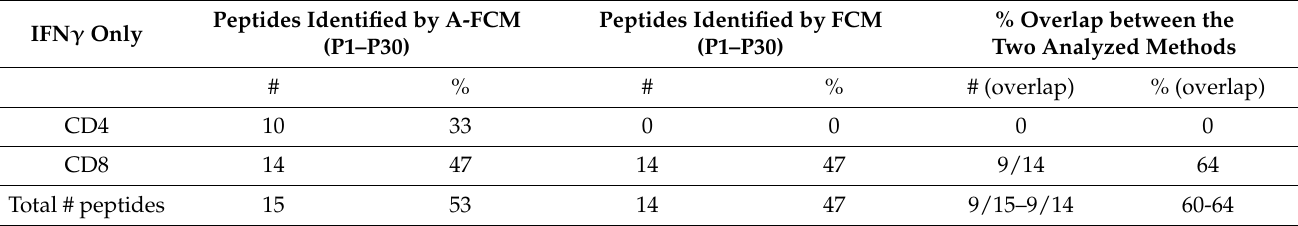
Table 1. Identification of peptides by using single function (IFN γ ) to three vaccine sets. CD4+ and CD8+ T cells responses to peptides in 3 sets of glioma vaccine (S1–3) and their booster were analyzed by activation marker-inclusive FCM (A-FCM) and FCM. Overlapping peptides are those identified both by A-FCM and by standard FCM (FCM).